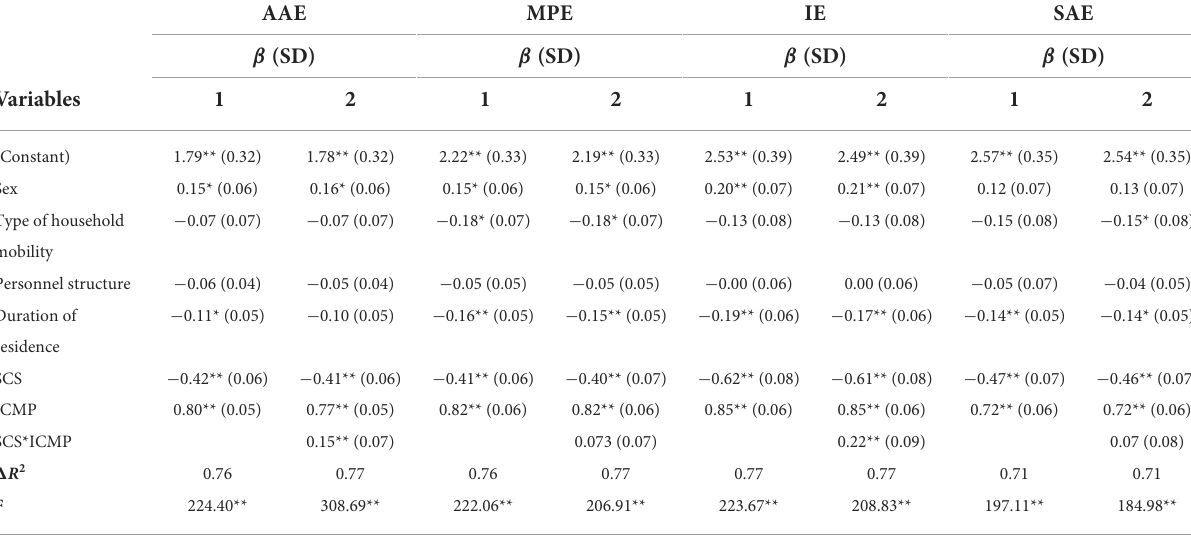
TABLE 7 Moderating effect of ICMP on the relationship between SCS and educational